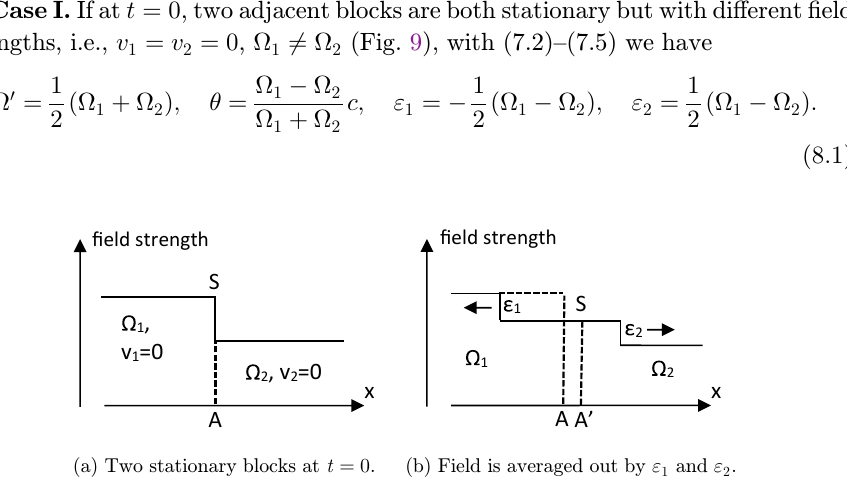
Fig. 9. Movement of interface with discontinuity in stationary